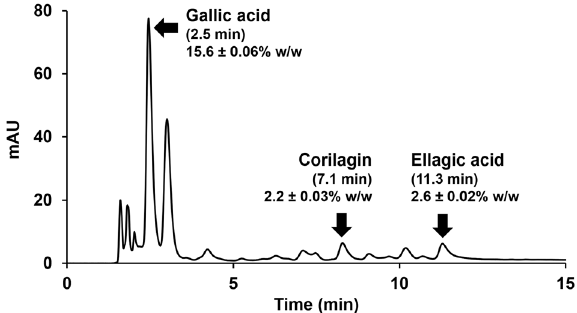
Figure 4. High-performance liquid chromatography (HPLC) chromatograms of black D. longan seed ethyl acetate extract